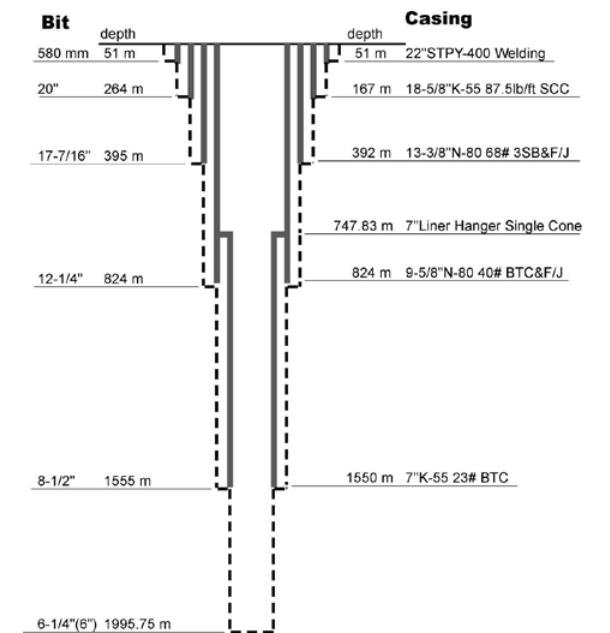
Figure 3. Casing system employed in the USDP-4 well.